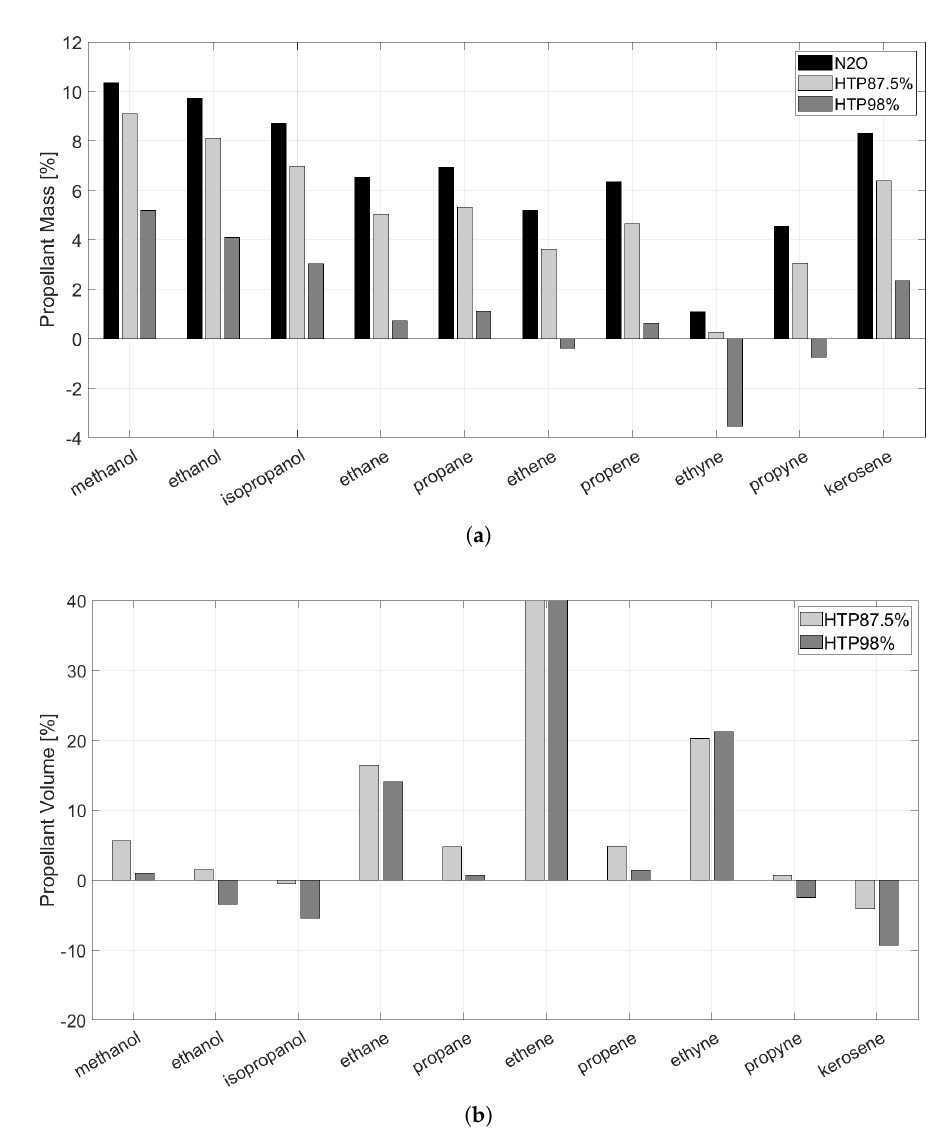
Figure 7. Relative mass and volume with respect to UDMH/NTO system for a generic upper stage mission (i.e., ∆ V =3000